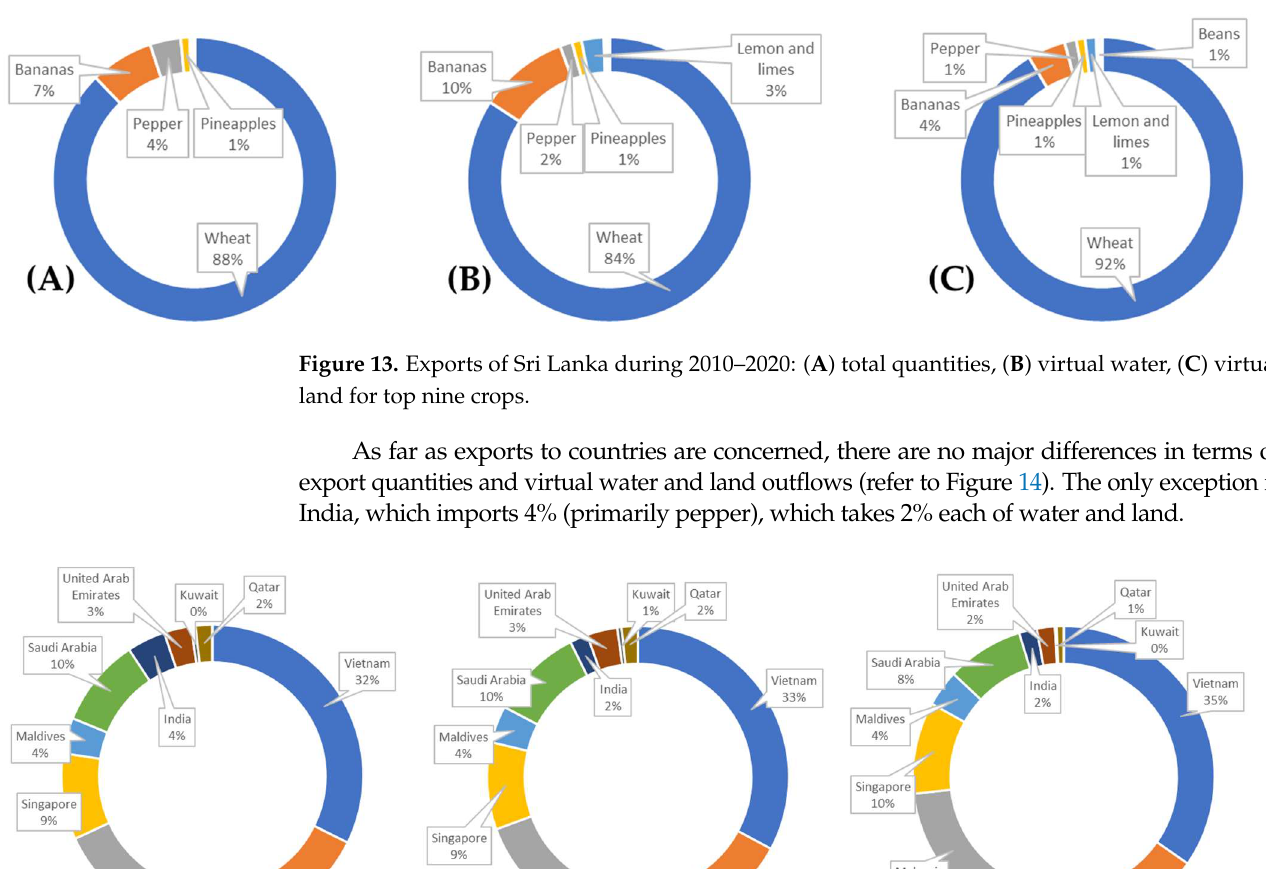
Figure 12. Top ten countries exporting crops to Sri Lanka during 2010–2020: ( A ) total quantities, ( B ) virtual water, ( C ) virtual land for top ten crops.